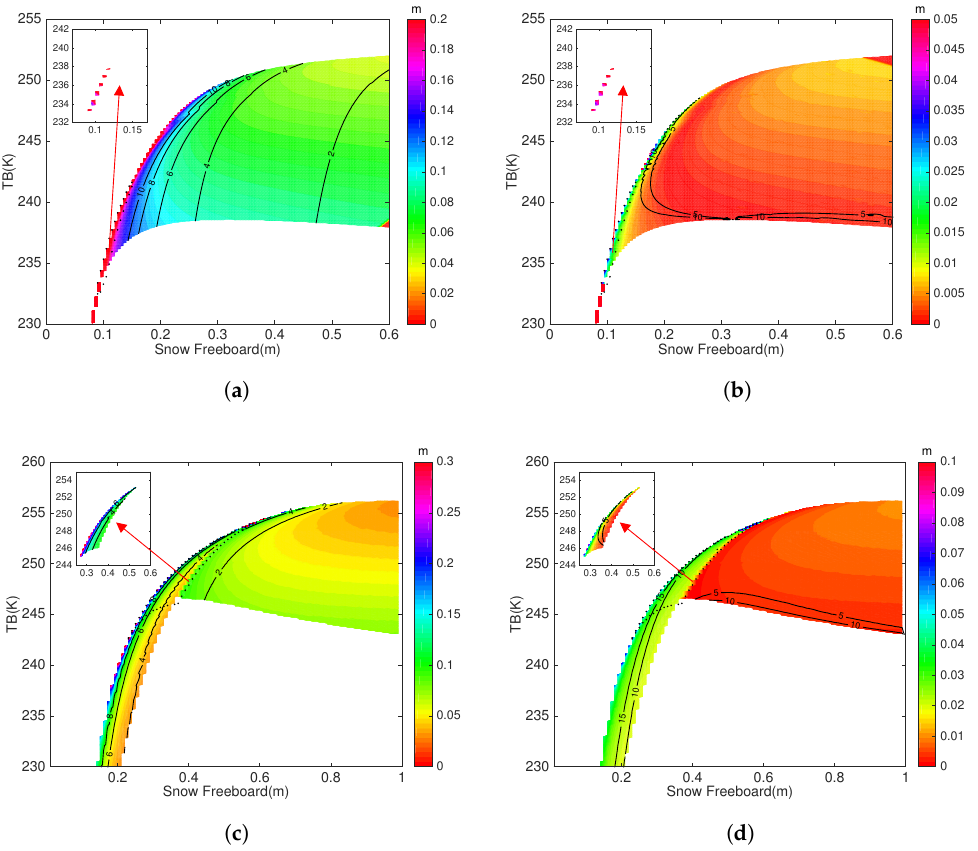
Figure 9. Same as Figure 7 but for the effect of the uncertainty in FB snow for the synergy of TB and FB snow . The order of subfigures are also the same as Figure 7, with ( a , b ) showing the sensitivity of the retrieved hi and hs to FB snow for FYI, and ( c , d ) the results for